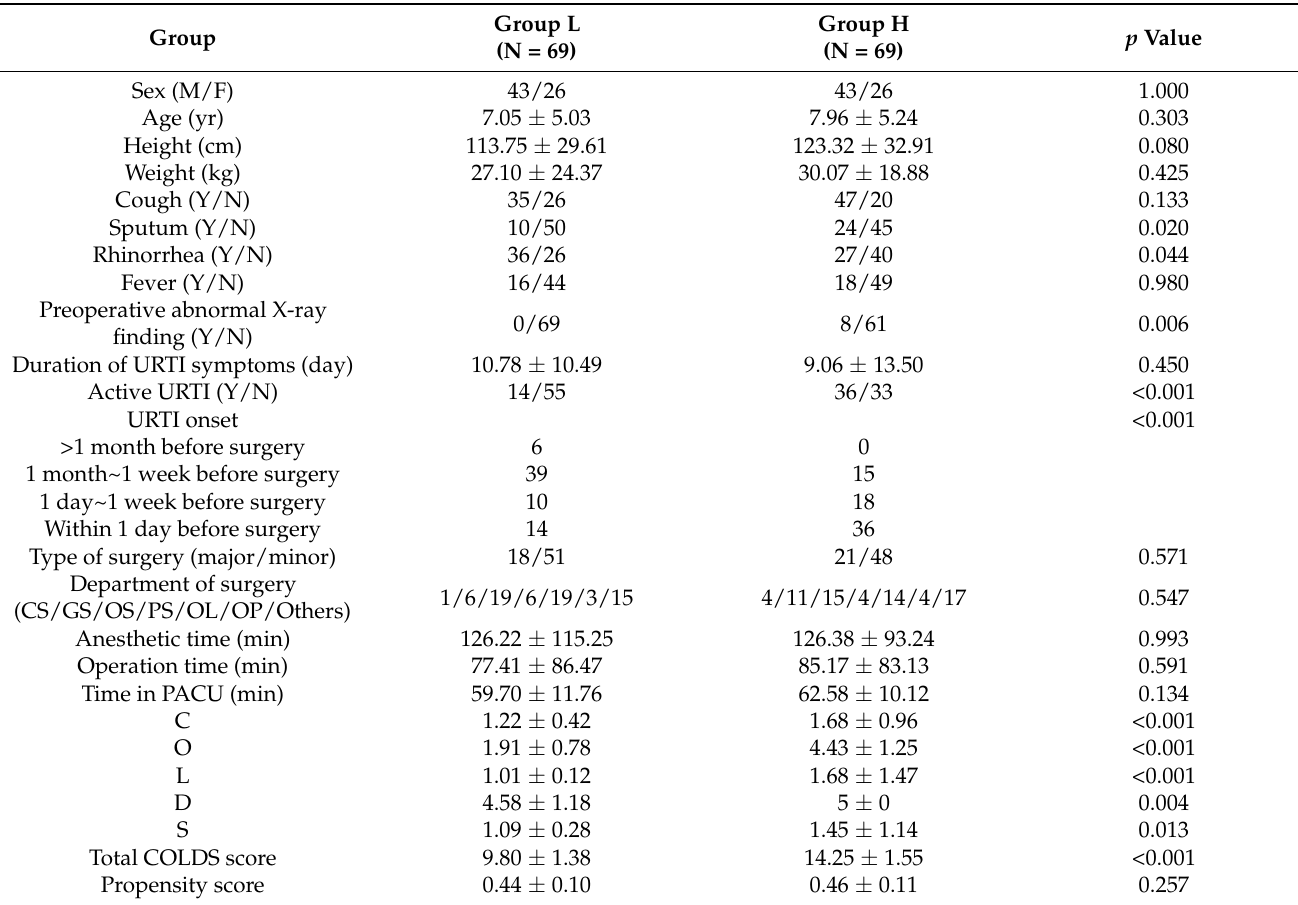
Table 2. Demographic information of low COLDS group (Group L) and high COLDS group (Group H) after propensity matching.